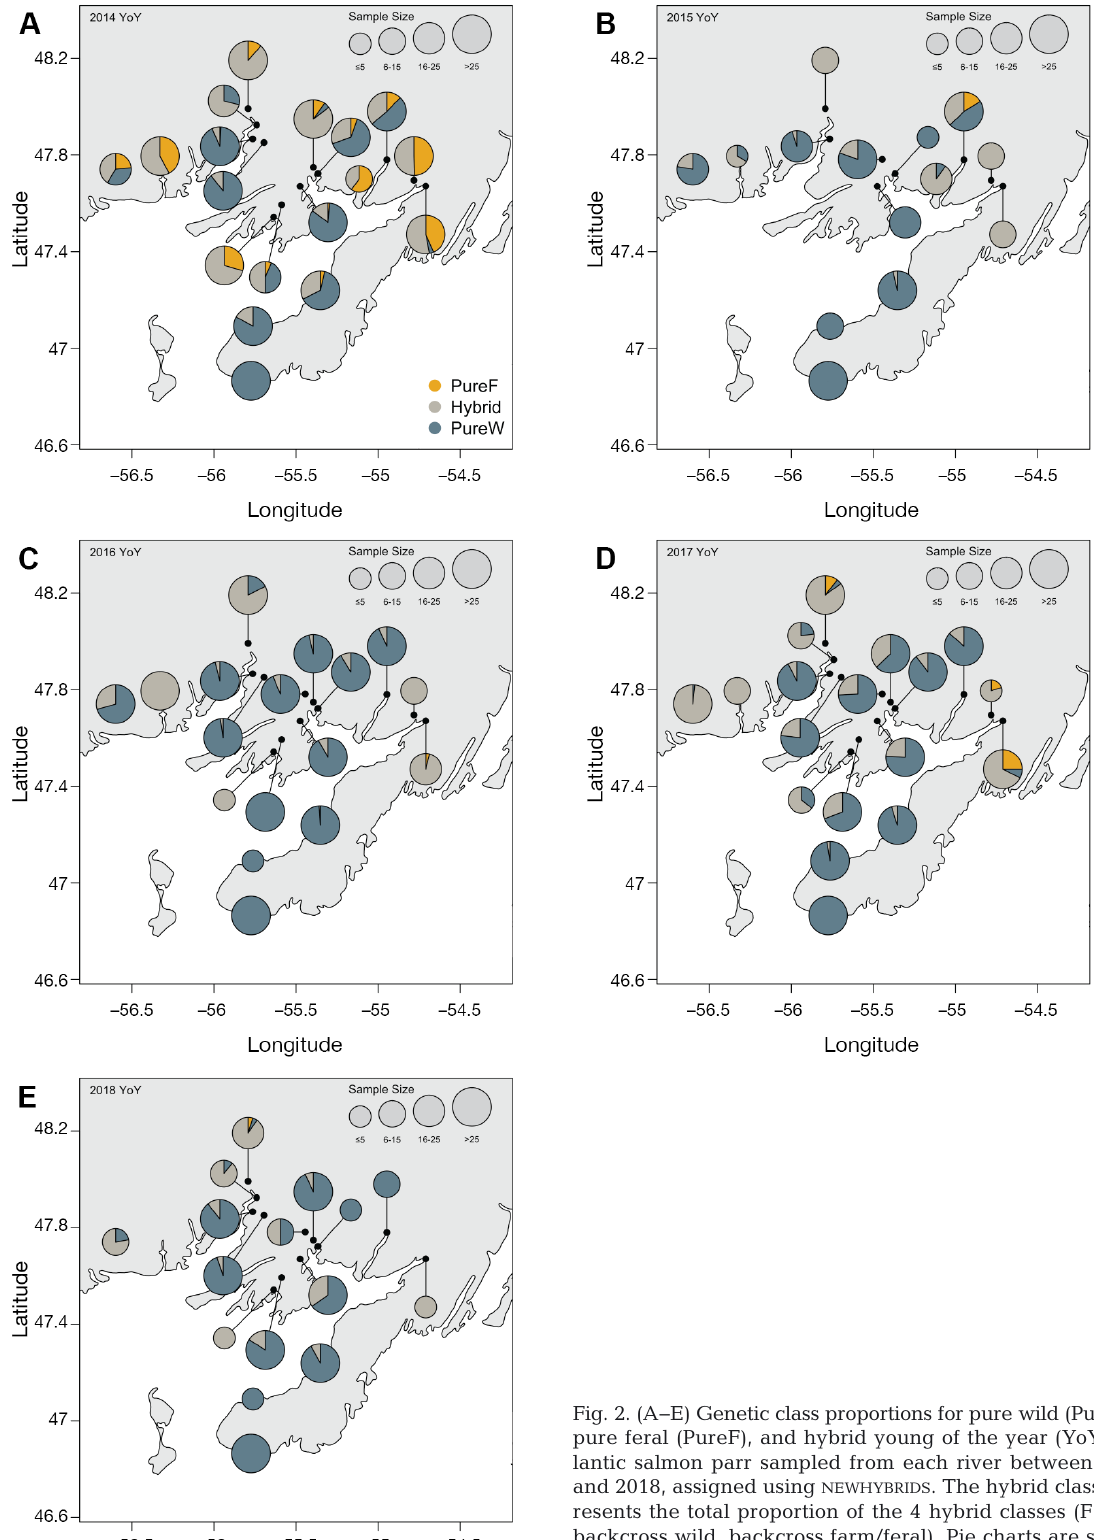
Fig. 2. (A−E) Genetic class proportions for pure wild (PureW), pure feral (PureF), and hybrid young of the year (YoY) At- lantic salmon parr sampled from each river between 2014 and 2018, assigned using NEWHYBRIDS . The hybrid class rep- resents the total proportion of the 4 hybrid classes (F1, F2, backcross wild, backcross farm/feral). Pie charts are scaled to represent sample sizes of parr successfully assigned to a genetic class for each